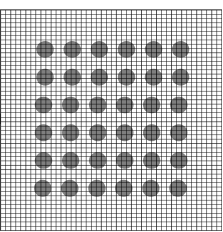
Figure 2. ROI divided into M × M